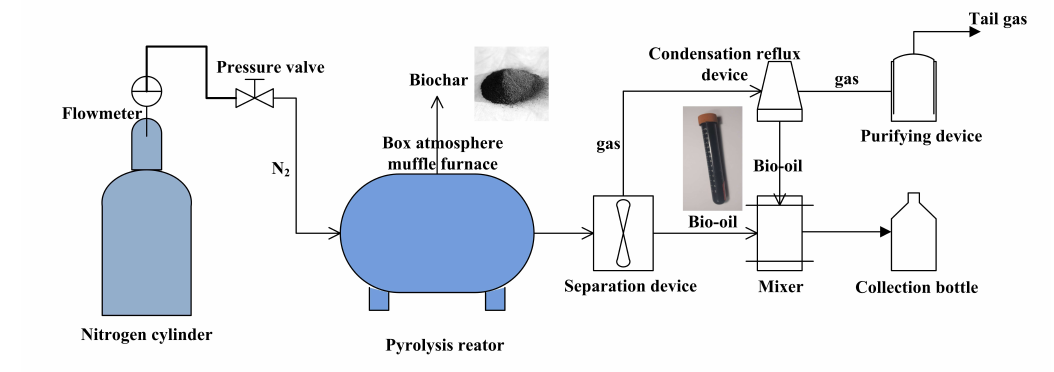
Figure 1. Schematic for pyrolysis process of Caragana korshinskii